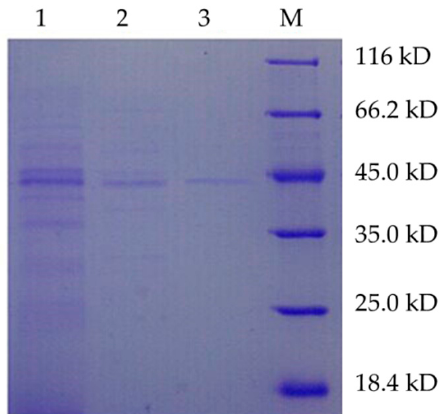
Figure 3. The fermentation experiments. ( a ) The fermentation curve of cell growth and enzyme activity, OD means optical density; ( b ) Effect of initial pH values on trypsin activity; ( c ) Effect of culture temperatures on trypsin activity; ( d ) Effect of carbon sources on trypsin activity and cell growth; ( e ) Effect of nitrogen sources on trypsin activity and cell growth; ( f ) Effect of metal ions on trypsin activity and cell growth. 2.4. Enzyme Purification The trypsin was purified by several procedures including HiPrep DEAE FF 16/10 and Superdex 75 10/300 GL. The results of trypsin purification procedures were presented in Table 3. The enzyme was purified to electrophoretic homogeneity (Figure 4) with 8.5-fold purification with 2.87% of yield.